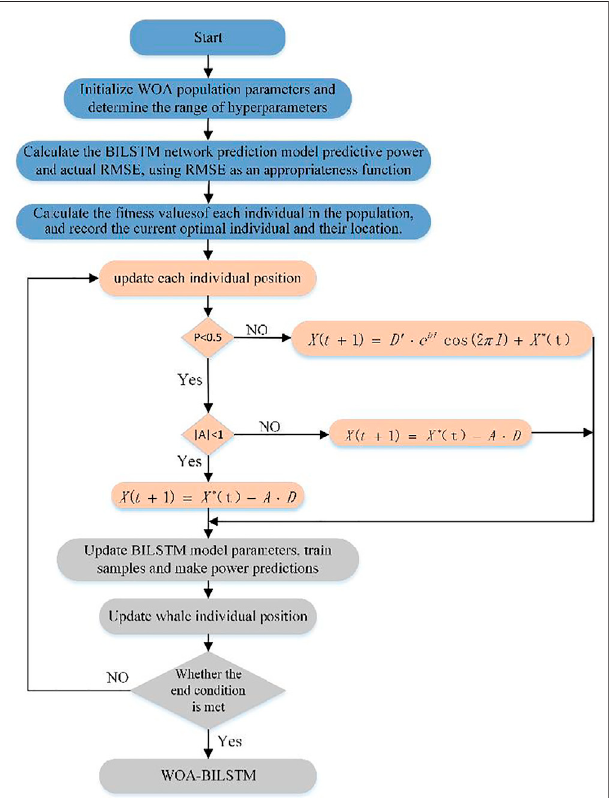
FIGURE 3 | Optimization process of the WOA-BILSTM model.